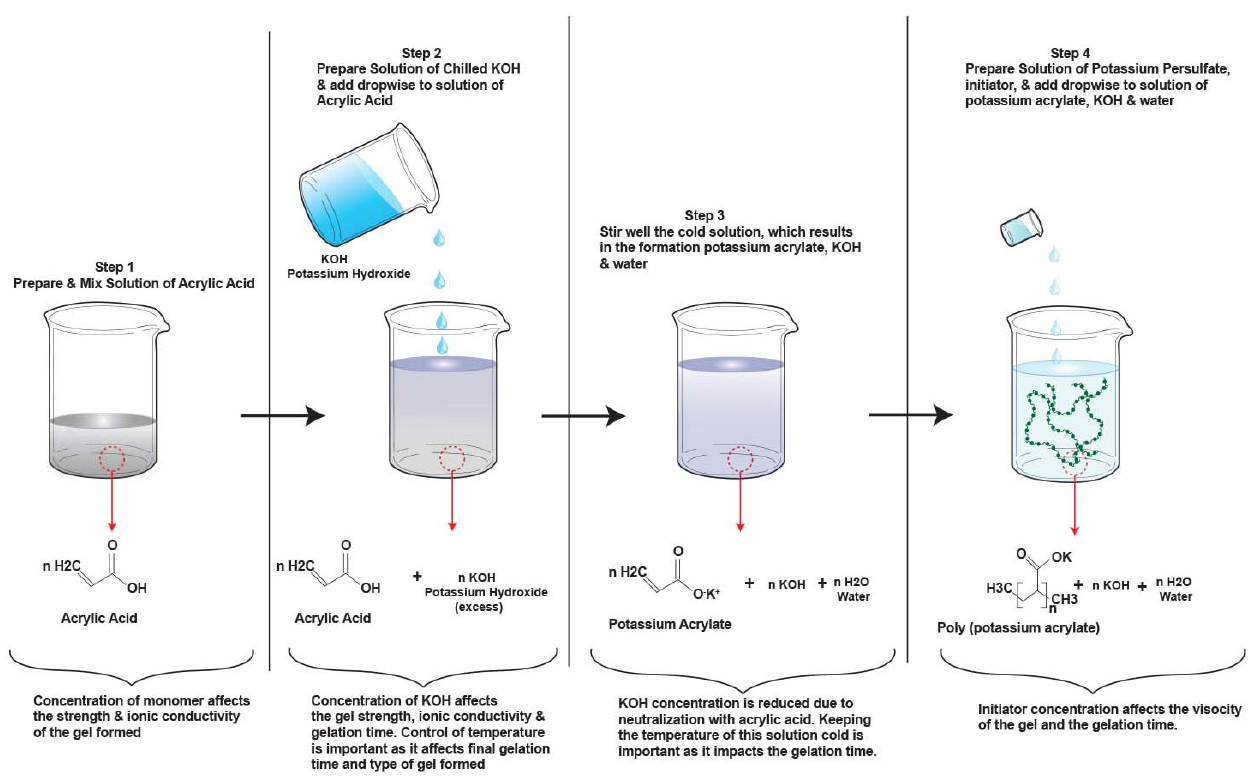
Figure 1. Schematic procedure showing the detailed steps for the free radical polymerization reaction of hydrogel electrolytes.